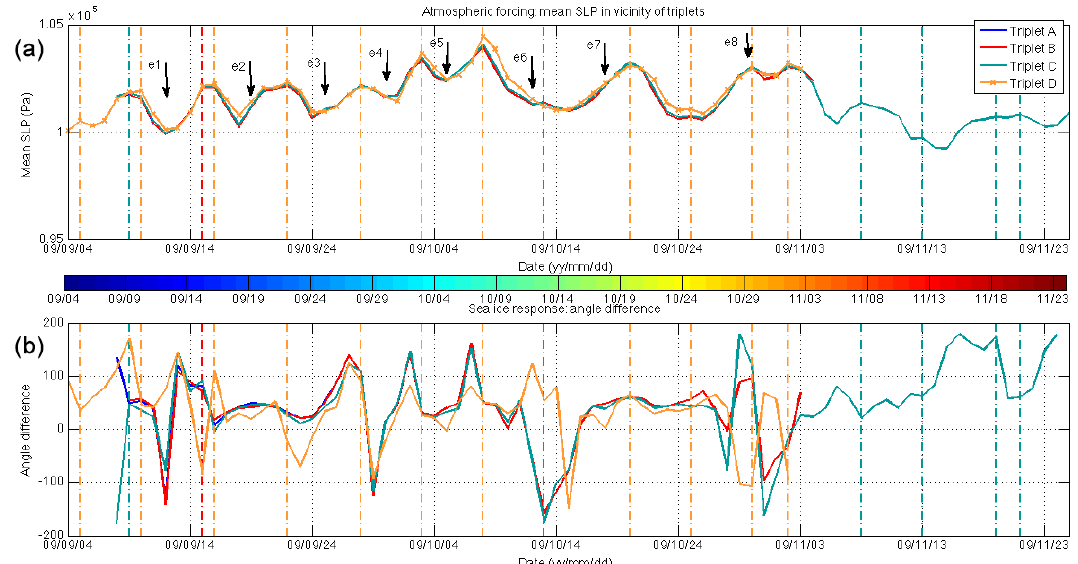
Figure 5. Atmospheric forcing and sea ice response. Mean SLP in the vicinity of triplets A to D highlighting atmospheric forcing (a) . Turning angle between surface winds and triplet centroid drift depicting sea ice response (b) . Colour bar indicates colours associated with centroid dates in Fig. 1b. Mean SLP in the vicinity of triplets A to D is uniform, with some differences in the vicinity of triplet D. By contrast, turning angles highlight spatial variability in ice drift for intervals between high SLP regimes and provide an initial indication of sea ice mechanics and deformation. Specifically, differences in turning angles highlight spatial (relative to distance from the coastline) differences in sea ice response to external forcing as the SLP high enters the region in the vicinity of the beacon triplets on 8 October 2009 and subsequent loss of coherence in the ice